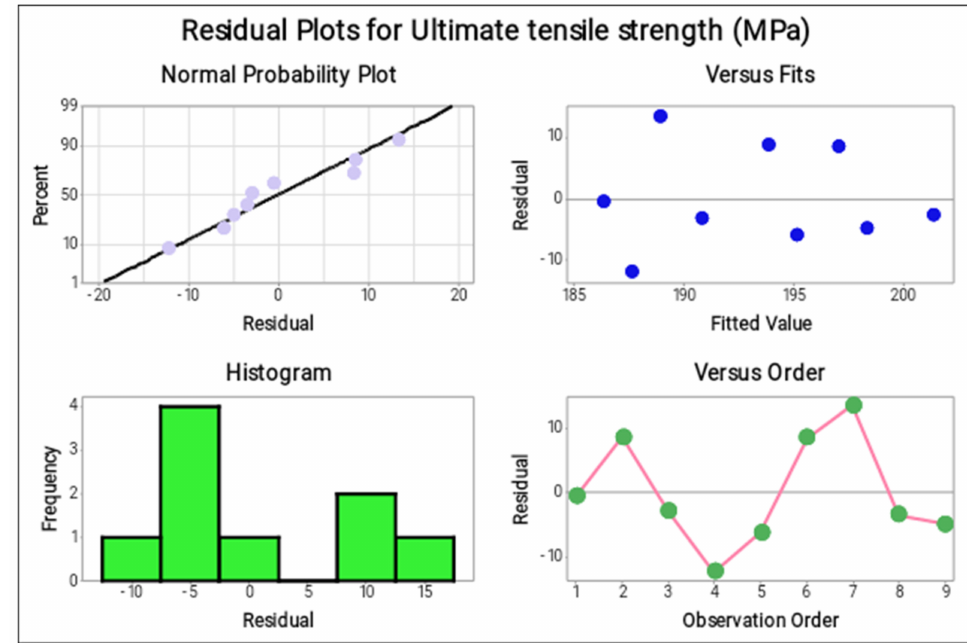
Figure 9. Residual plots (Ultimate tensile